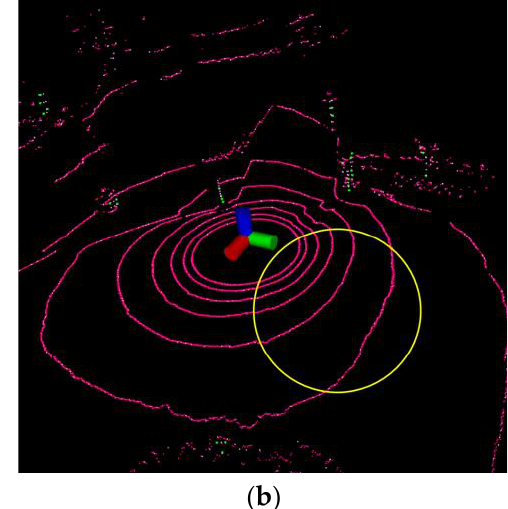
Figure 6. Point cloud distortion caused by rotation. ( a ) Before distortion correction; ( b ) After distortion correction.